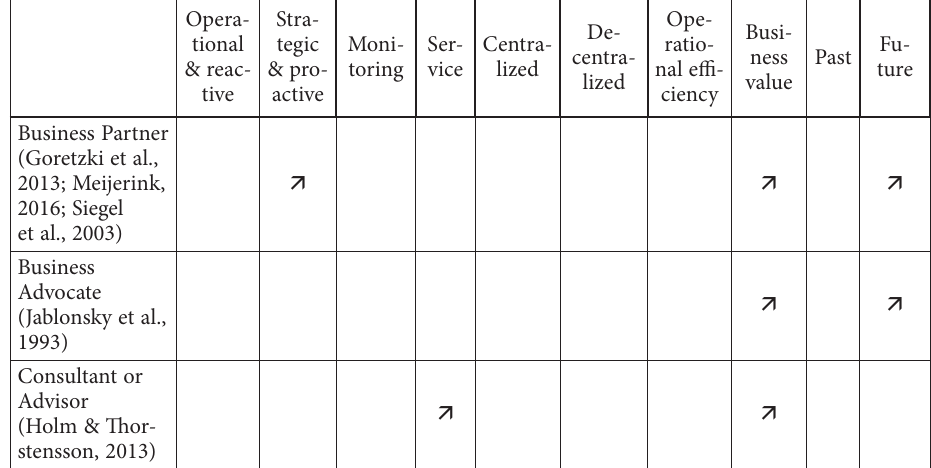
Table 1. Types of controllers by organizational approach to management control